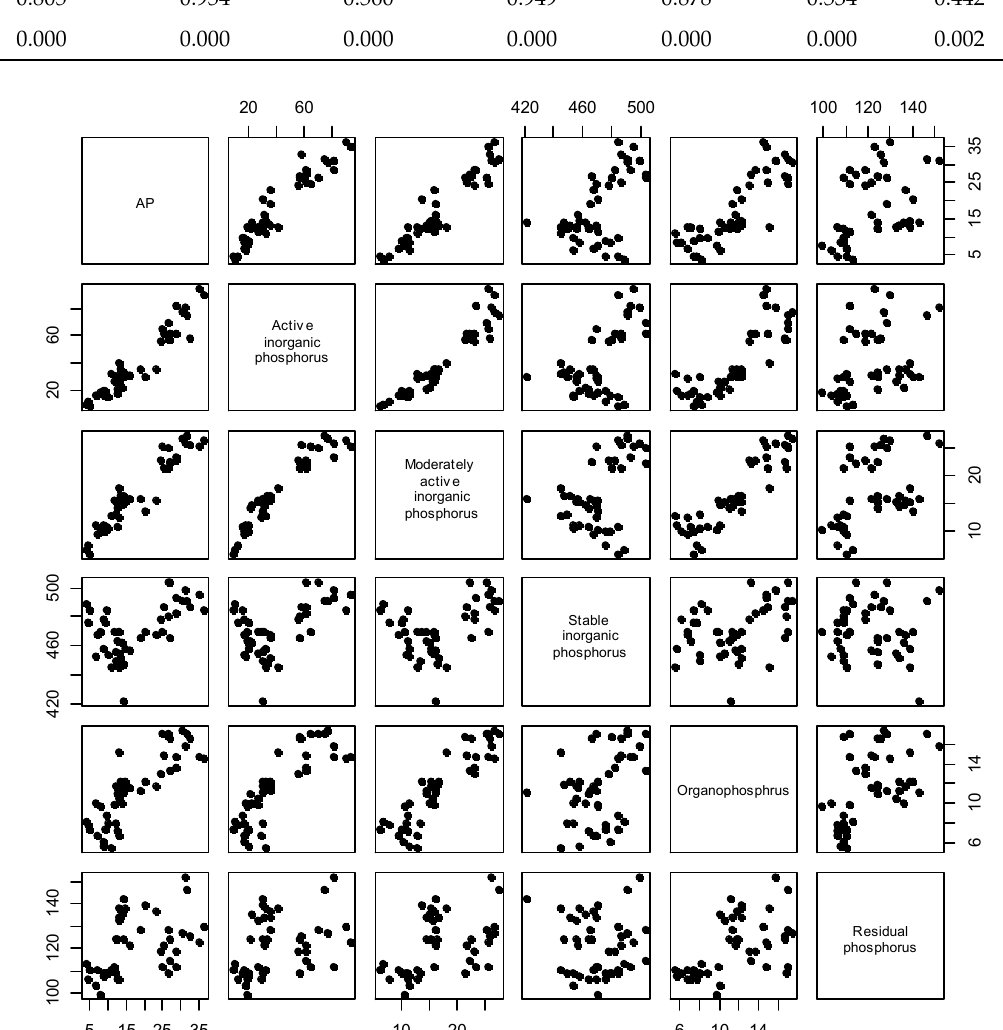
Figure 3. Correlation diagram between available phosphorus and various forms of phosphorus in Hedley classification.